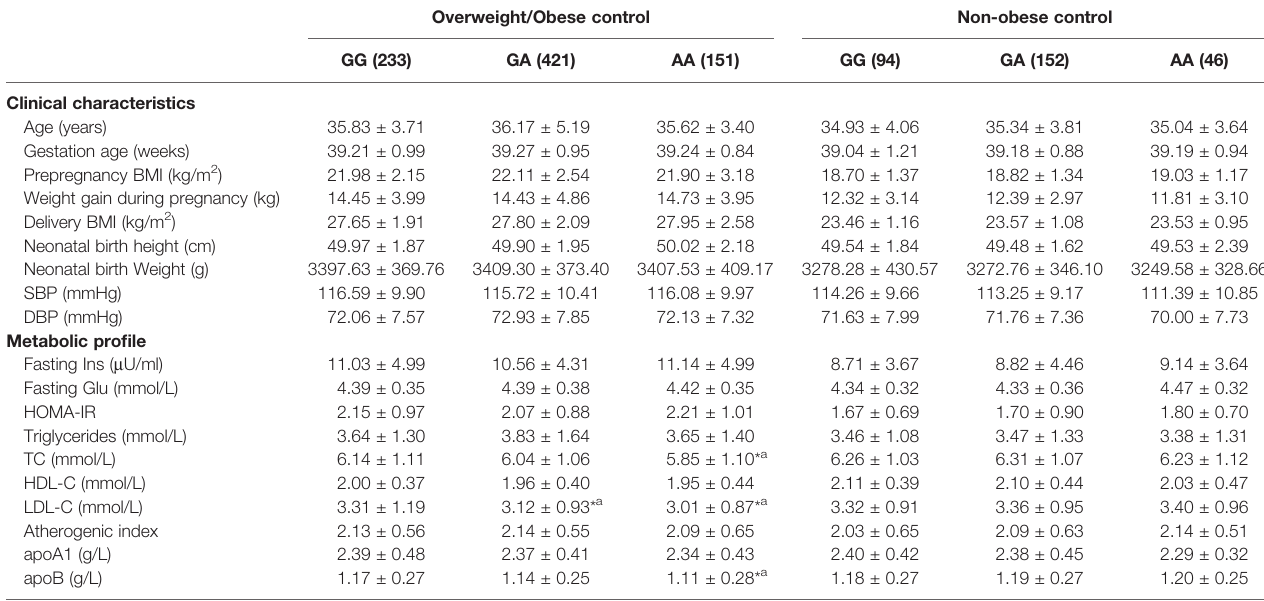
TABLE 6 | Clinical characteristics and metabolic pro fi le of ABCA1 rs2230806 genotypes in overweight/obese and non-obese control subjects.